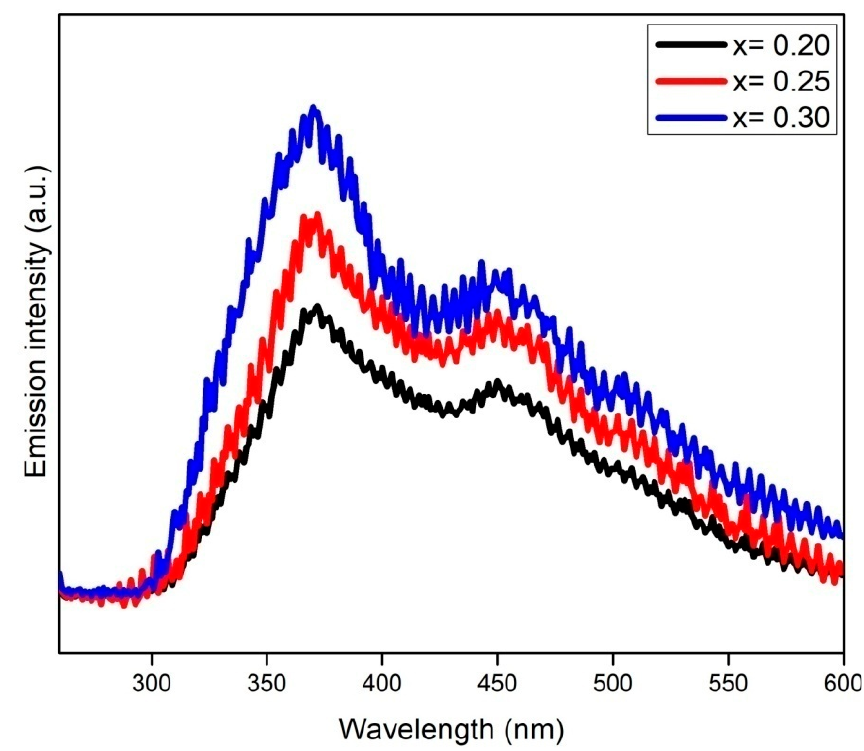
Figure 9. PL spectra of the Cr x ZnS (x = 0.20, 0.25, and 0.30) catalyst.